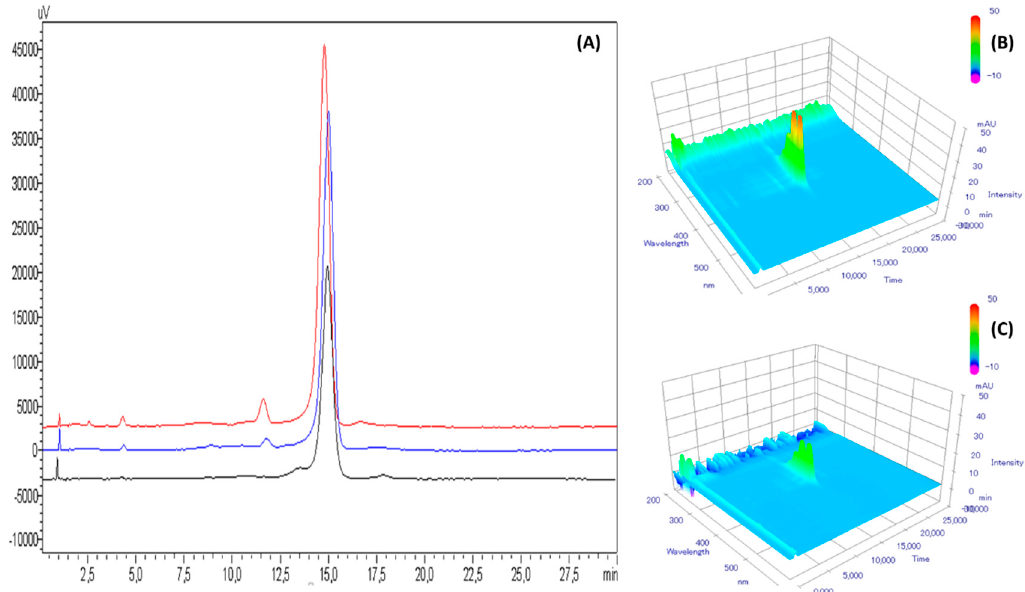
Figure 4. ( A ) Chromatograms at 408 nm of amphotericin B deoxycholate (diluted 1/100th to the theoretical concentration of 25 µg/mL) at day 0 (red curve), after 168 days at 5 °C storage (blue curve) and 25 °C (black curve); with diode array detector screening after 168 days at 5 °C ( B ) and at 25 °C ( C ). µV and mAU: units of intensity of signal measured by the UV-visible detector.